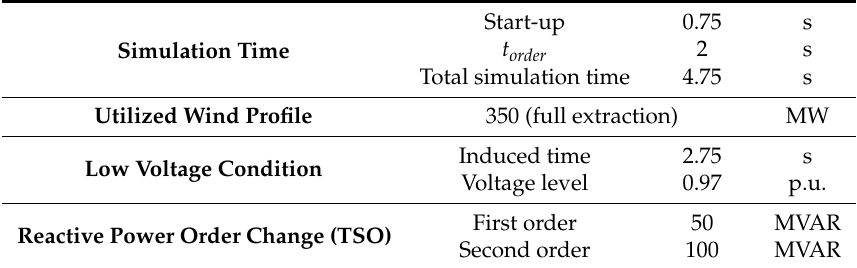
Table 2. Imposed numerical value in basic case